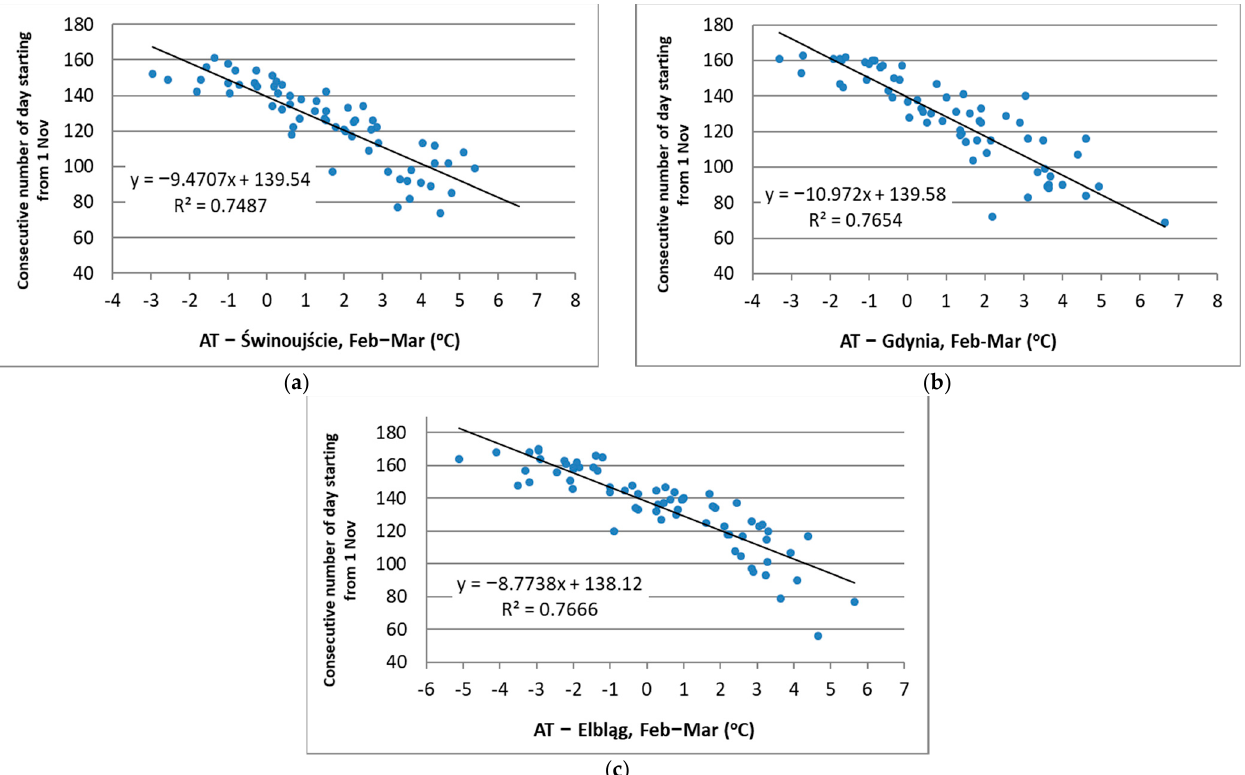
Figure 6. Correlations between the date of the last ice disappearance (L) on ( a ) Szczecin Lagoon; ( b ) Puck Lagoon; ( c ) Vistula Lagoon, with Feb–Mar air temperatures (ATs) through the period 1950/51–2019/20, along with the regression line equation and determination coefficient (R 2 ).